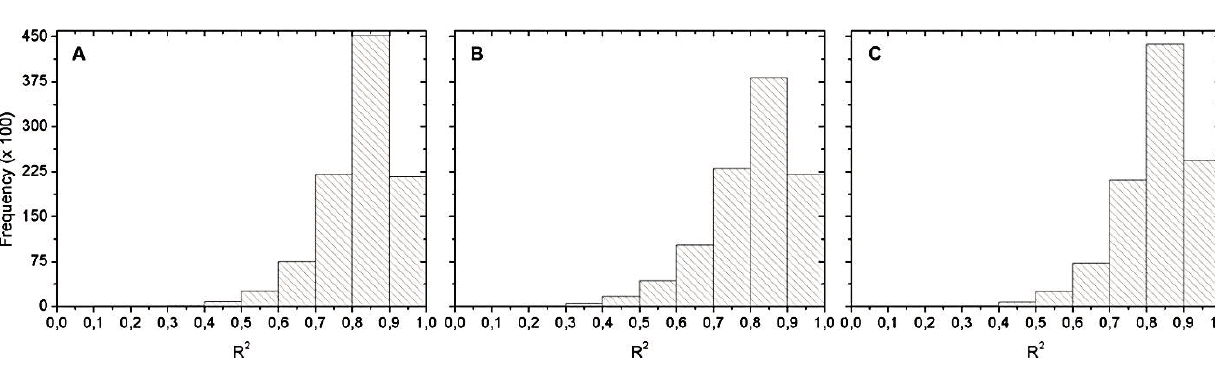
Figure 6. Histograms of the R 2 distribution for: ( A ) May 2012; ( B ) September 2012; and ( C ) April 2013. Hyperspectral data with chl- a values below 20 µg·L − 1